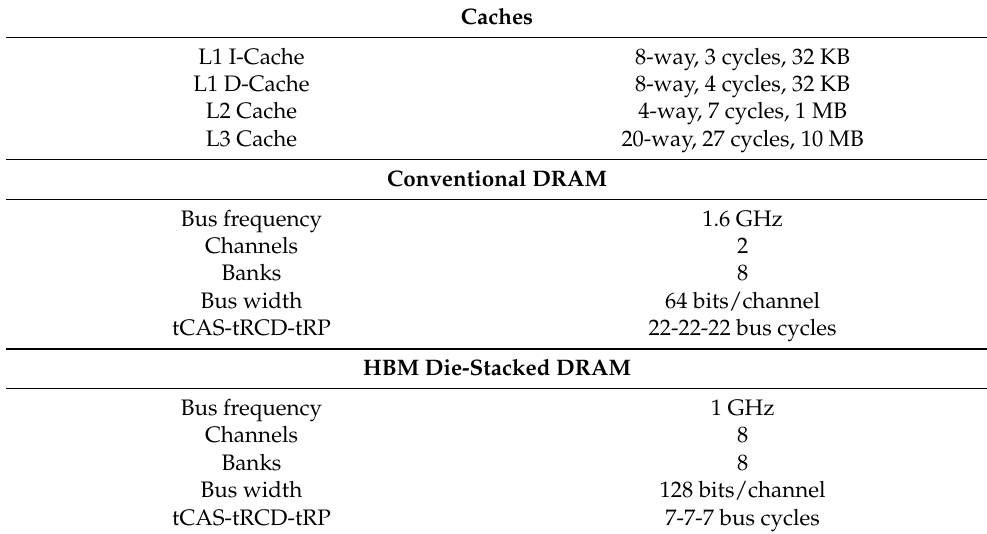
Table 2. Memory configurations.